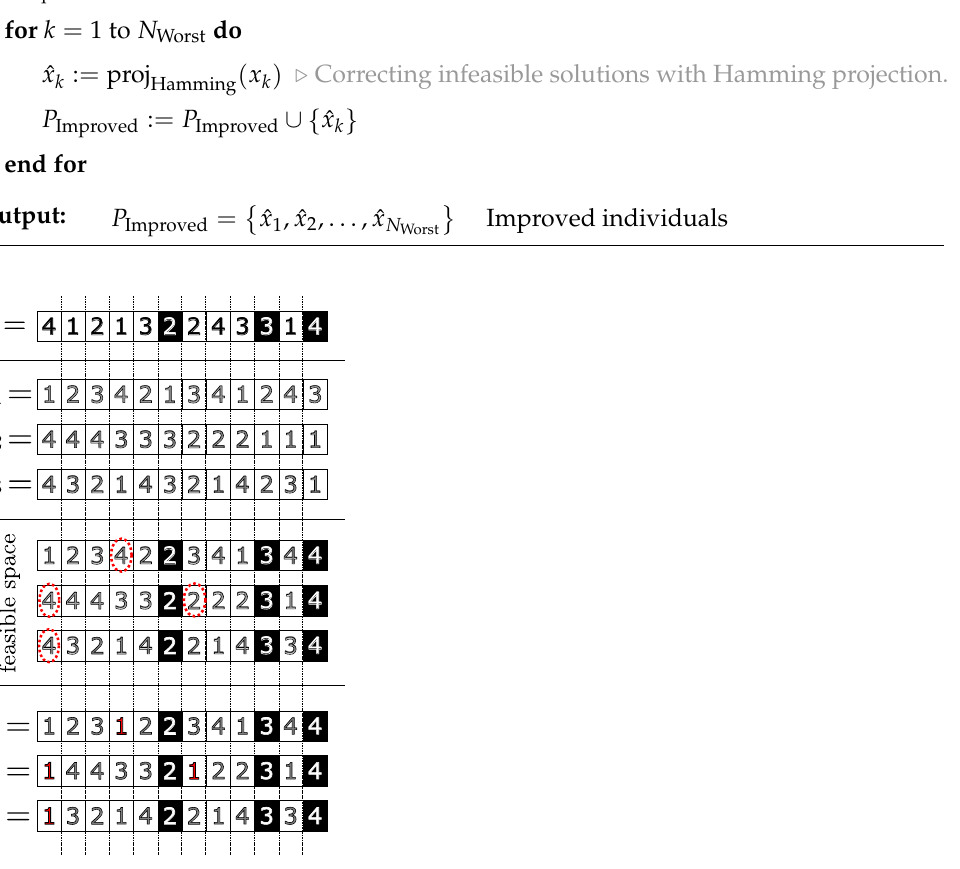
Figure 4. Genetic improvement proposed. The genes highlighted on a black background are the most relevant, while the genes highlighted with the red sectioned circle are those that need